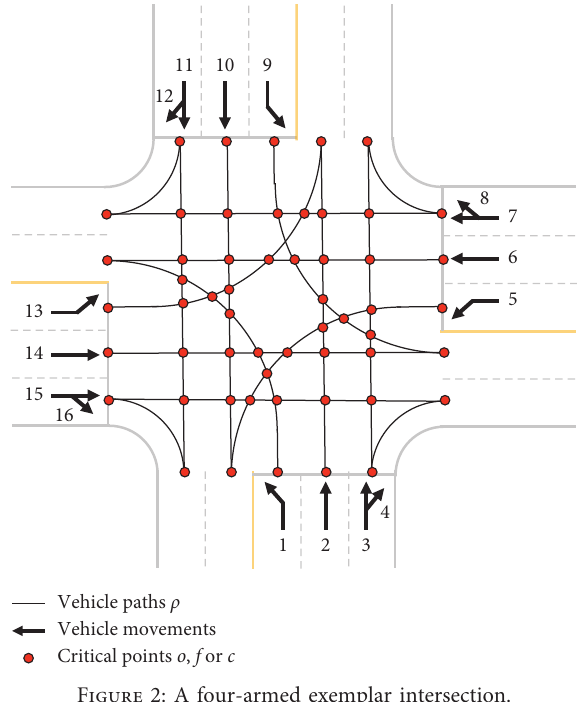
Figure 2: A four-armed exemplar